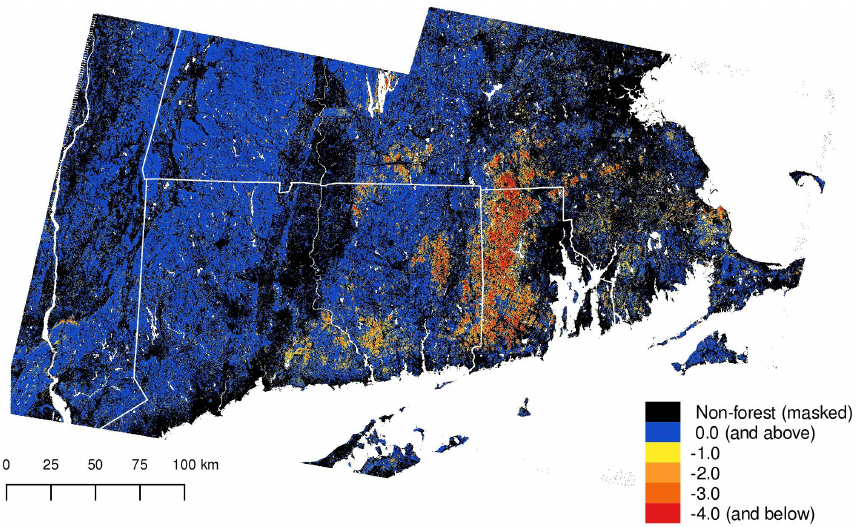
Figure 4. 2016 Landsat Time Series (LTS) integrated condition assessment, mid-June through September 2016 for Southern New England. Forest condition in blue areas did not differ from predicted values, whereas darker reds indicate increasing deviation from the 2005–2015 forest condition. Non-forested areas based on NLCD 2011 are shown in black and water bodies appear as white.